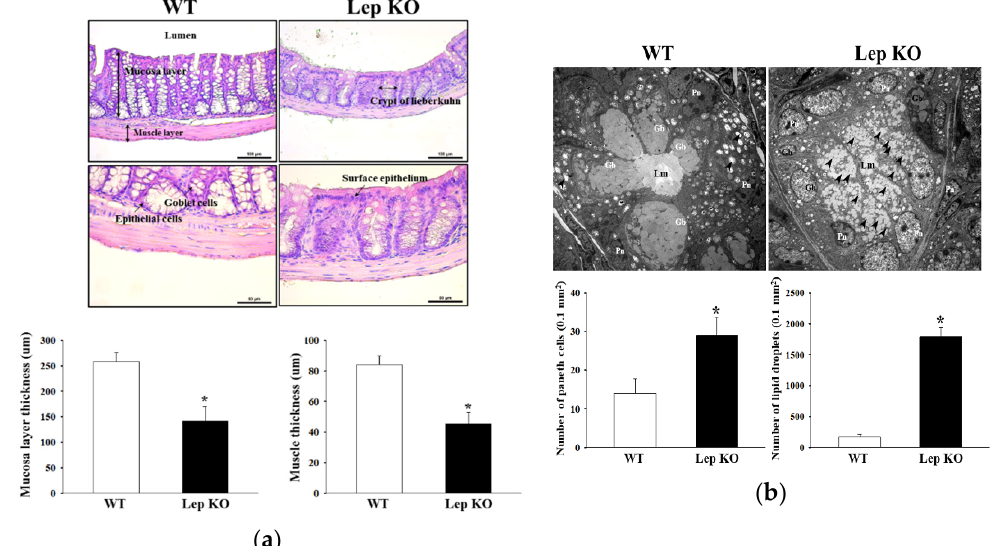
Figure 4. Histological structures and ultrastructure of the transverse colon. ( a ) The hematoxylin and eosin (H&E)-stained sections of the transverse colon from the WT and Lep KO mice were observed at 100 × and 400 × magnification using an optical microscope. The histopathological parameters were determined using the Leica Application Suite (Leica Microsystems). Three to five mice per group were used for histological analysis, and each parameter was measured in duplicate in two different slides; ( b ) The crypt ultrastructure of the transverse colon in the WT and Lep KO mice was observed by TEM at 4000 × magnification. The number and size of goblet cells and the number of mucin droplets (arrowhead) per each goblet cell were determined using Leica Application Suite software. Two to three mice per group were used to prepare the TEM slide, and three parameters were assayed in duplicate in each test. The data are reported as the mean ± SD. * indicates p < 0.05 compared to the WT mice. Abbreviations: WT, Wild type; KO, Knockout type; Pn, Paneth cells; Gb, Goblet cells; Lm, Lumen.